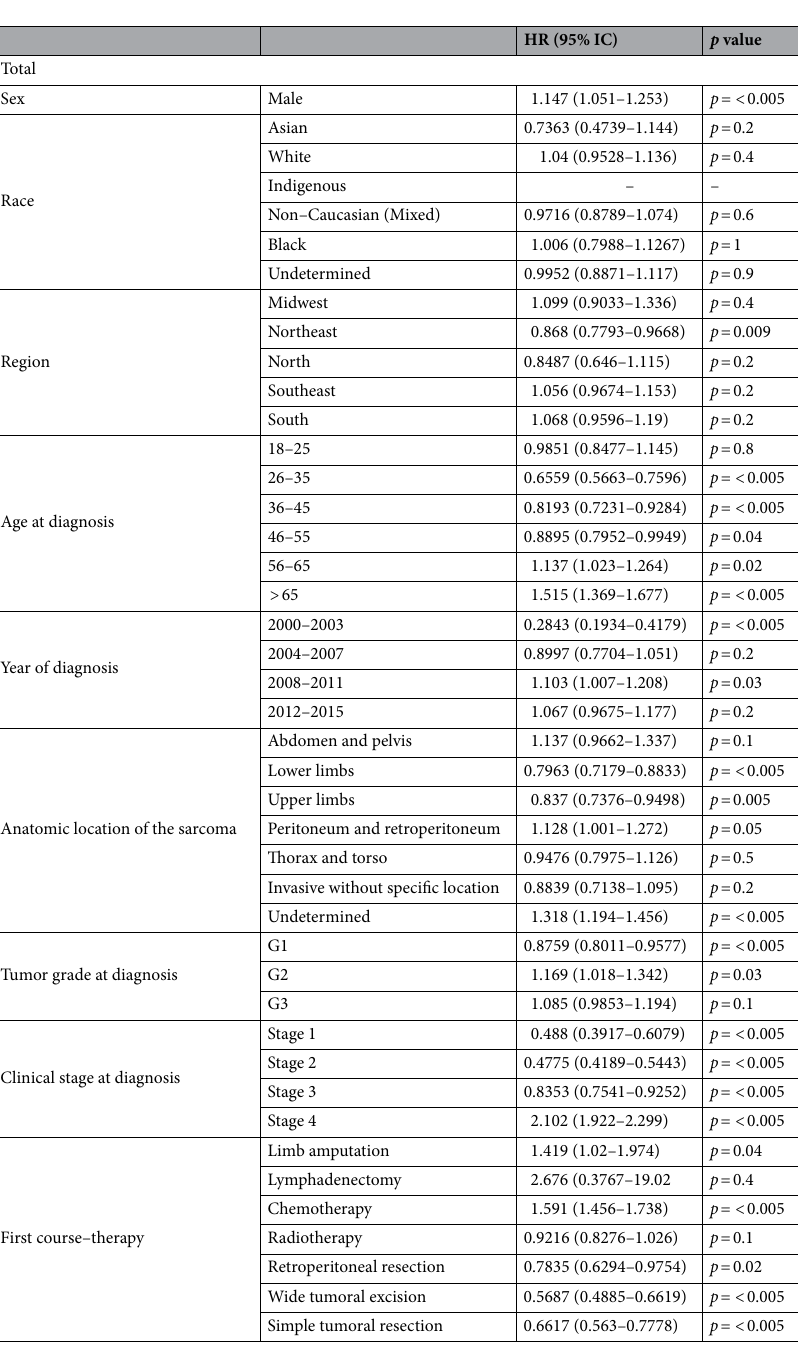
Table 3. Univariate analysis of sub cohort: patient and tumor characteristics impact on survival. p value determined by Score (logrank) test and value refers to the comparison between groups. HR: hazard ratio; CI: confidence